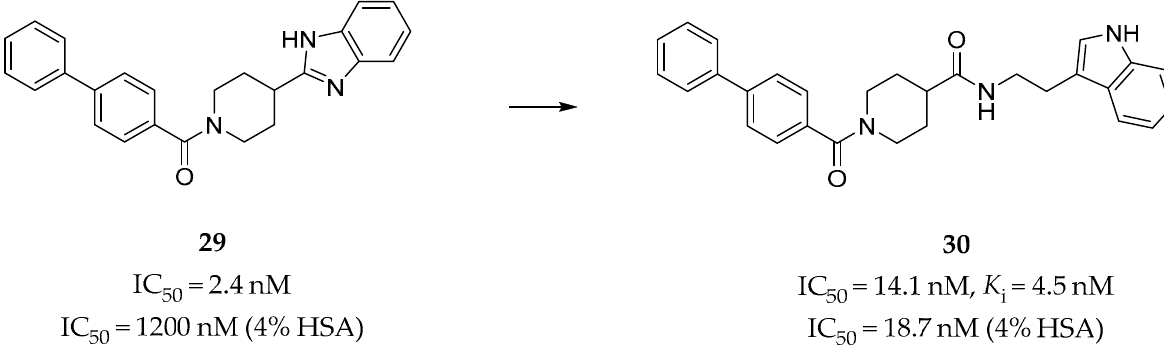
Figure 9. Representative biphenyl amide derivative ( 30 ) as 5-HT 2B R antagonists [144].